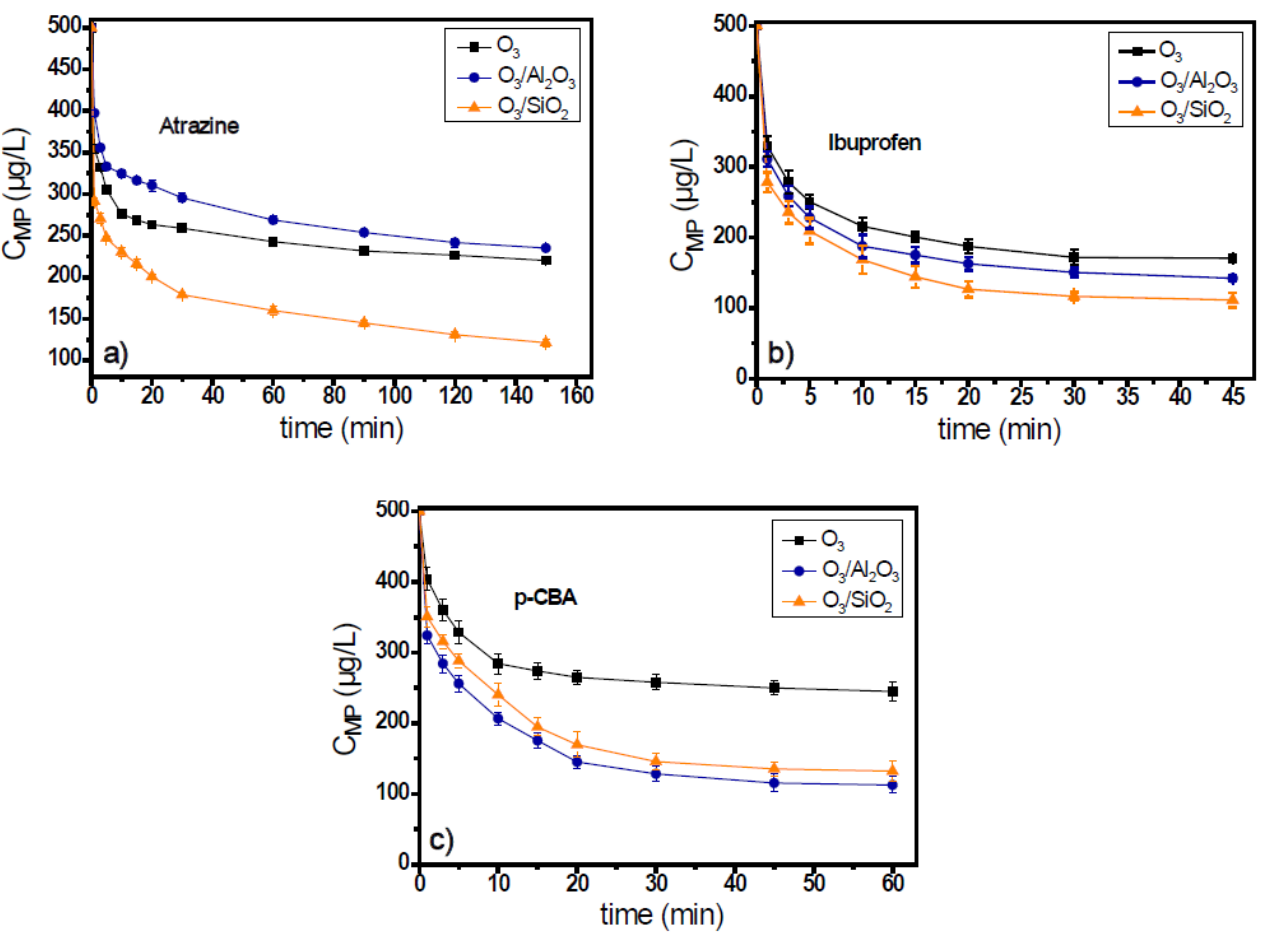
Figure 2. Degradation of ozone-resistant micropollutants: ( a ) atrazine, ( b ) ibuprofen, and ( c ) p-CBA during the application of catalytic ozonation with the use of Al 2 O 3 or SiO 2 as potential catalysts, compared to the single ozonation in natural potable water matrix. Experimental conditions: C MPs 500 µ g/L, C catalyst 0.5 g/L, C O3 2 mg/L, pH 7.8, Temperature 23 ± 2 ◦